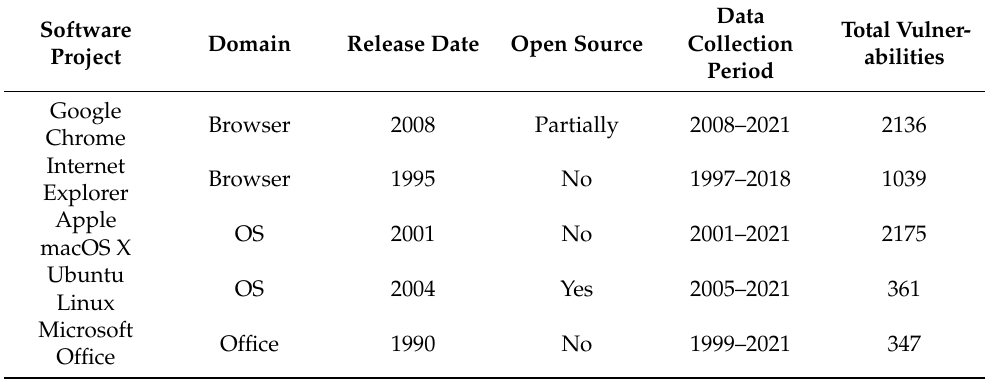
Table 3. Selected software systems and their descriptive statistics.